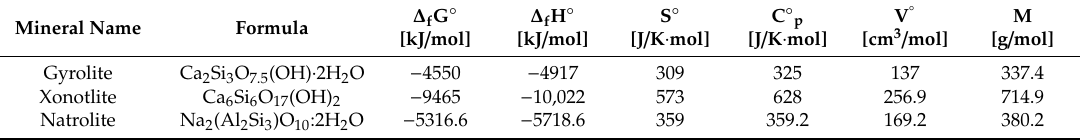
Table 3. Standard molar thermodynamic properties of gyrolite, natronite and xonotlite [62].